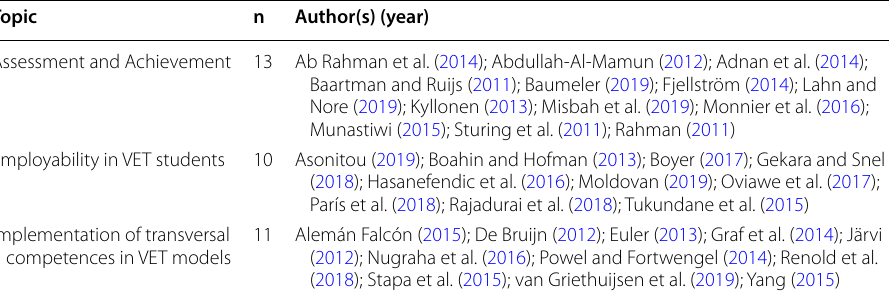
Table 1 Articles analysed by topic Topic n Author(s) (year)